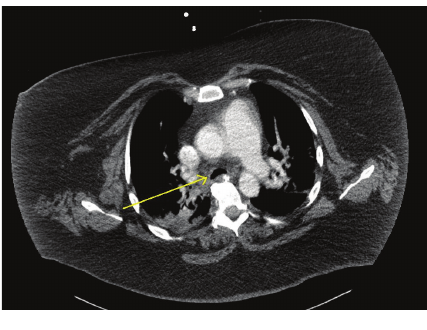
inspiratory time was also increased to improve oxygenation. A chest X-ray again demonstrated low lung volumes with some mild patchy opacities interpreted as likely atelectasis by the radiologist. These infiltrates resolved over the next two days as her oxygen saturation gradually